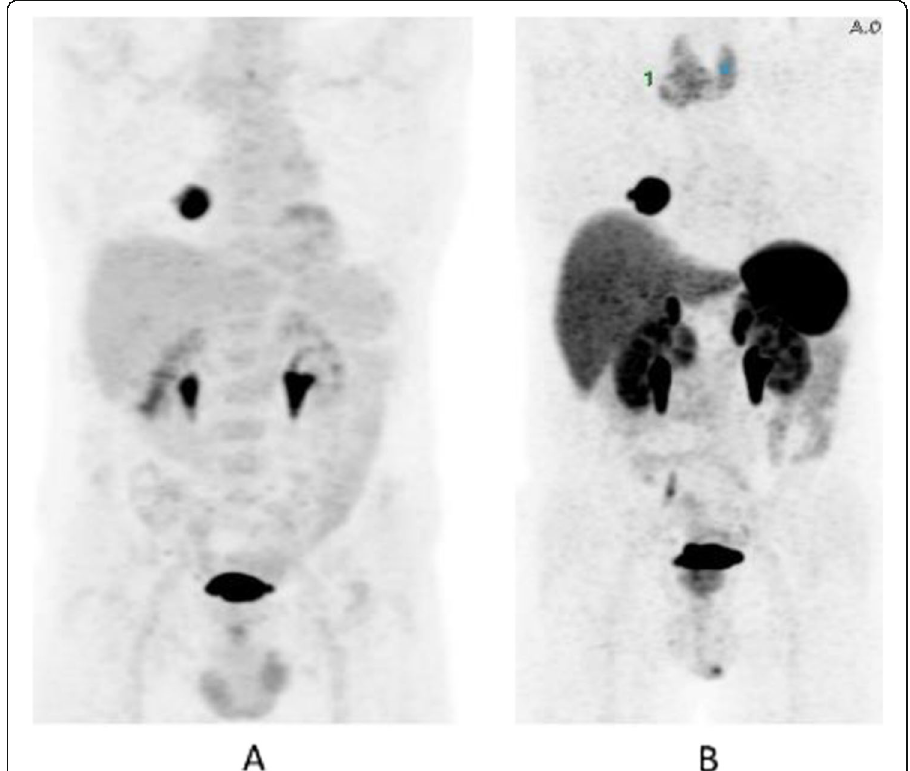
Fig. 52 68 Ga-DOTA peptide, staging of NET lung primary, comparison with FDG. Clinical history : 65 y.o. man. Staging of a lung mass with FDG PET and biopsy indicated a moderately differentiated NET (grade 2, Ki67 8%). Consequently, the patient underwent a second PET using 68 Ga-DOTANOC to stage the disease more accurately. PET/CT findings : increased focal uptake in FDG PET in the right lung, without any other findings ( a MIP). 68 Ga-DOTANOC showed intense uptake in the lung and in the thyroid due to a known De Quervain thyroiditis ( b MIP)